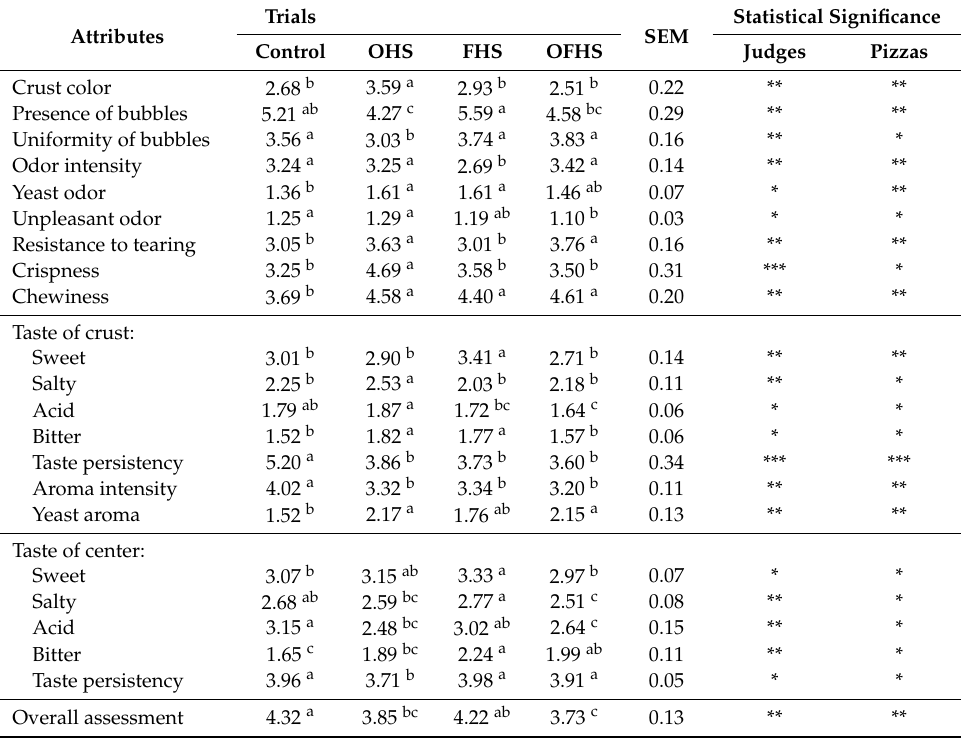
Table 3. Sensory characteristics of experimental seasoned